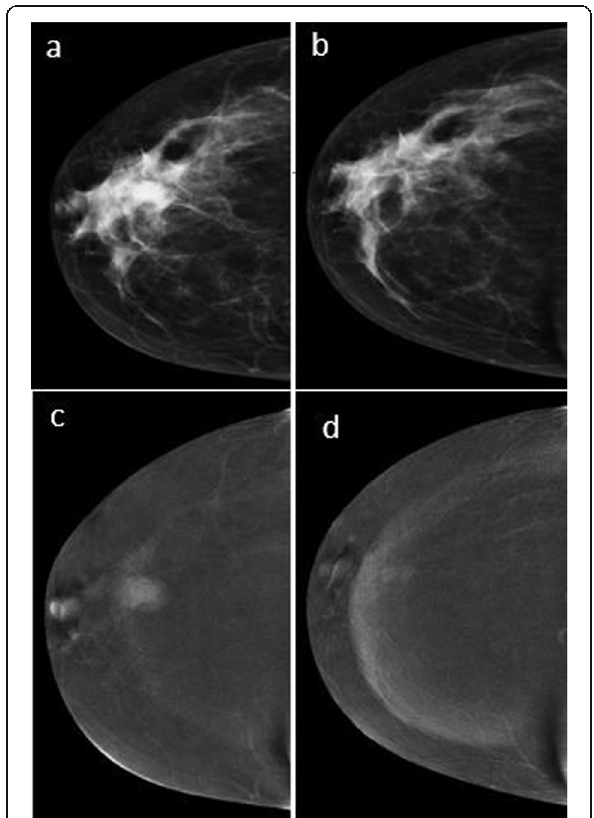
Fig. 4 a Pre-NAC mammogram; UOQ focal asymmetry. b Post-NAC mammogram; reduction in size. c Pre-NAC CESM; an enhancing mass. d Post-NAC CESM CC view showing type I shrinkage. Both RECIST 1.1 and combined response evaluation; partial